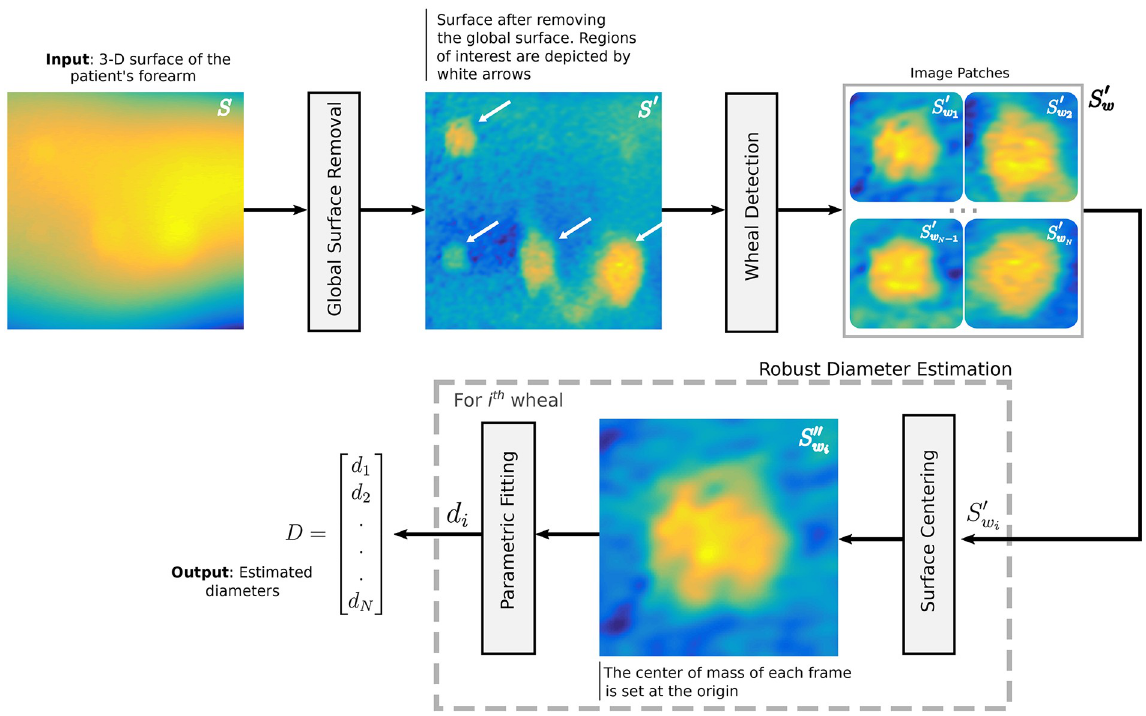
Fig 4. Block diagram illustrating the proposed method for the measurement of skin wheals. S and D denote the 3D surface of the patient’s forearm and the estimated diameters, respectively. The other variables are intermediate outputs of every stage; their meaning is given in the text.